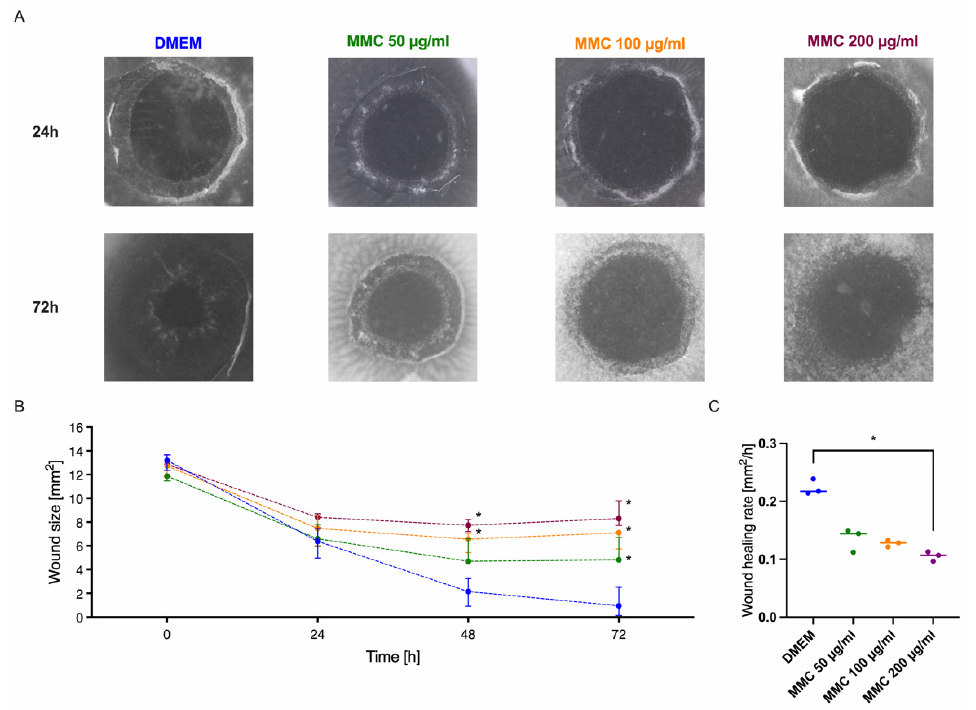
Figure 7. Effect of mitomycin C on corneal wound healing. The regeneration capacity of ex vivo cultured corneas was determined under the influence of the cytostatic agent mitomycin C. ( A ) Images, which illustrate the wound healing performance were shown for 24 h and 72 h. ( B ) The corneal lesion was generated with a 4 mm biopsy punch. After 24 h, 48 h and 72 h of culture the wound size was calculated. Different concentrations of mitomycin were tested: 0 µg/mL (DMEM, blue line), 50 µg/mL (green line), 100 µg/mL (orange line) and 200 µg/mL (purple line). ( C ) The wound healing rates were also calculated for the different mitomycin c concentrations evaluating the period from 0 to 48 h. Sample size n = 3. Statistically significant differences are indicated as *: p < 0.05.